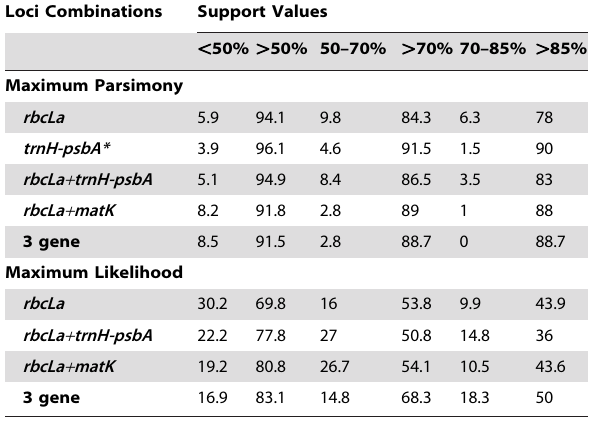
Table 3. Cumulative parsimony ratchet support values for all nodes of each phylogeny generated with sequence data from one to three barcode